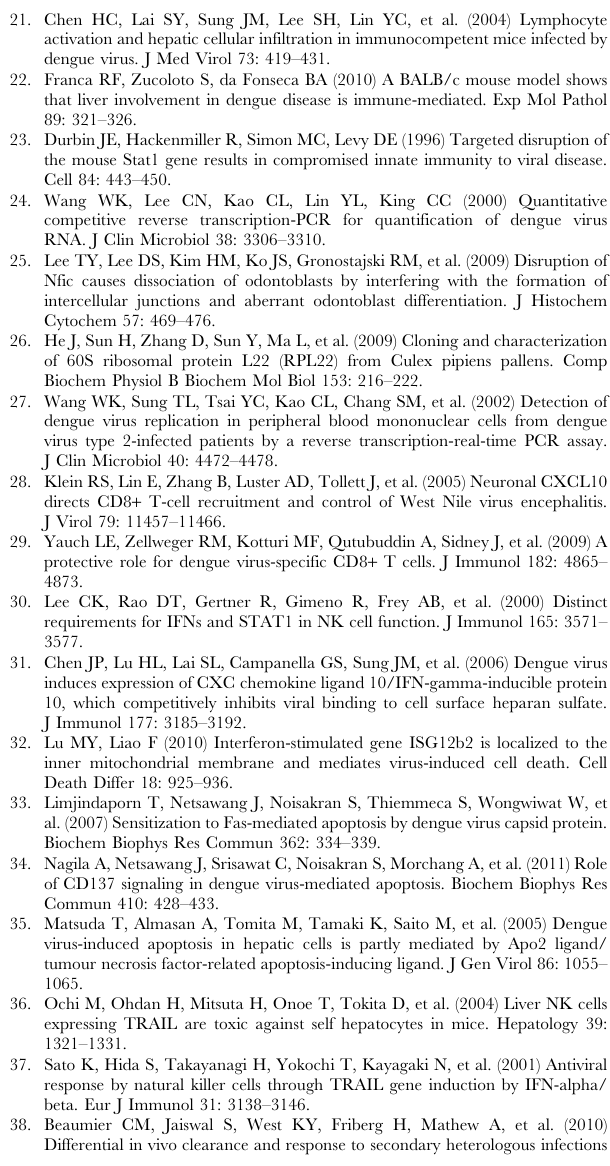
Figure 5. Intrahepatic as well as splenic CD8 + T cells recognize NS4B 99–107 epitope. (A) Liver lysates were collected from uninfected and infected wild type and STAT1 KO mice. Arrow points to cleaved caspase 3. Data presented are representative of three independent experiment ( n= 3 per time point in each experiment). (B) Splenocytes were isolated from wild type and STAT1 KO mice at day 3 (empty), 5 (darkened), and 7 (hatched) after infection and at day 5 after UV-inactivated DENV injection (horizontal line). (C) IHLs were isolated from wild type and STAT1 KO mice at 5 days after DENV infection. Splenocytes and IHLs were stimulated with or without (control) indicated peptides. The percentages of IFN c -producing CD8 + T cell within the total CD8 + T population were analyzed by flow cytometry. Data presented are representative of four independent experiments ( n= 3 per time point in each experiment). ** P value , 0.01 compared with the control group.